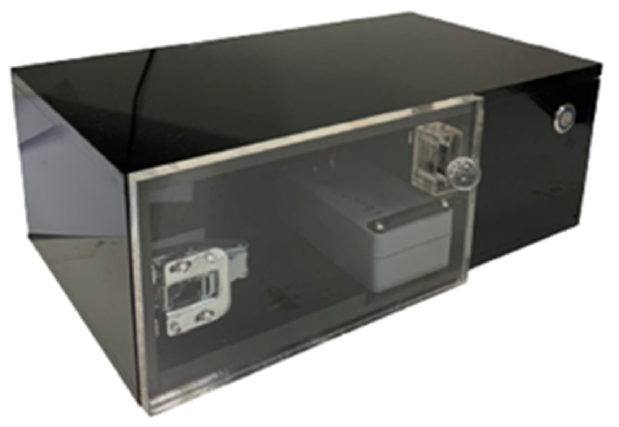
Figure 21. Circuit diagram of the control board of a sub-cabinet.